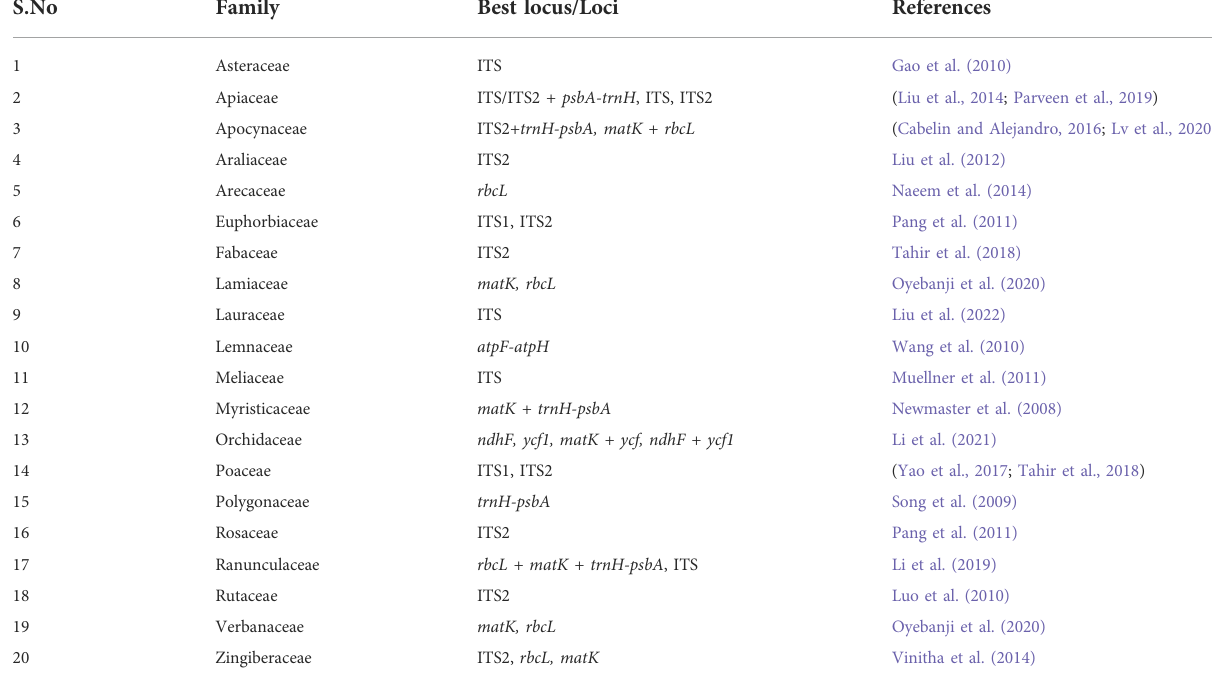
TABLE 2 List of recommended DNA barcode loci for medicinal plant